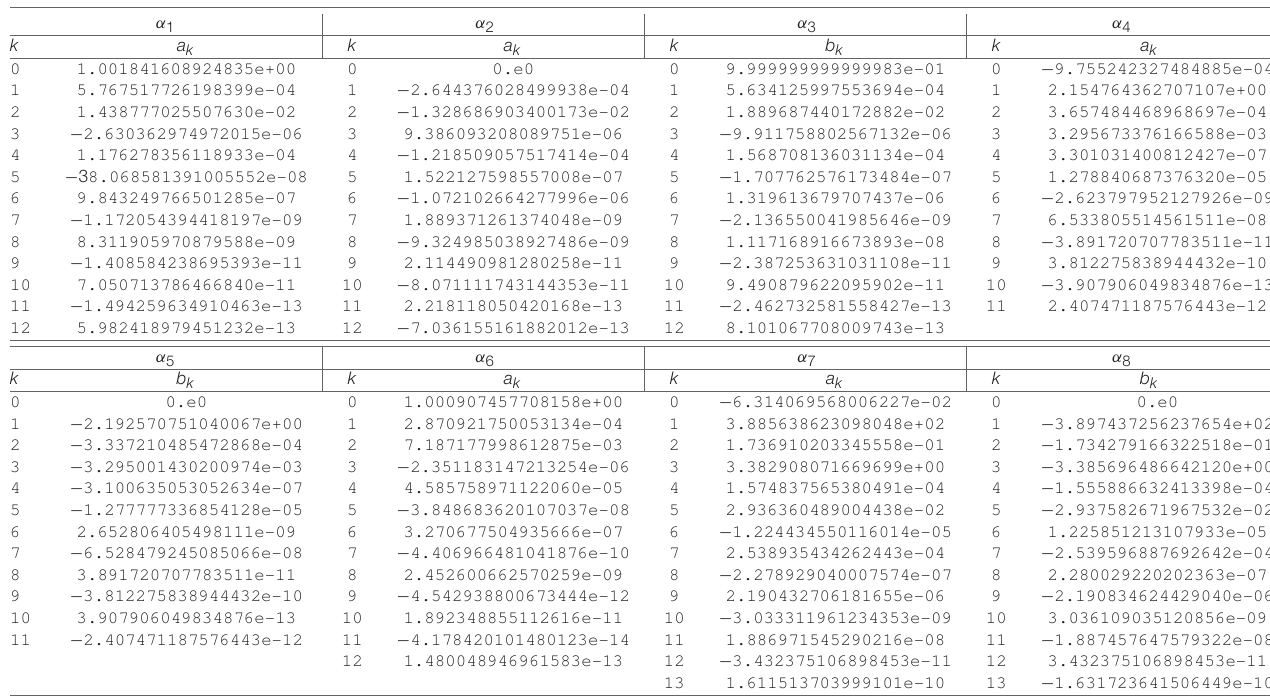
TABLE 4 | Coefficients of the functions α j , j = 1, ... ,8, in (5). α